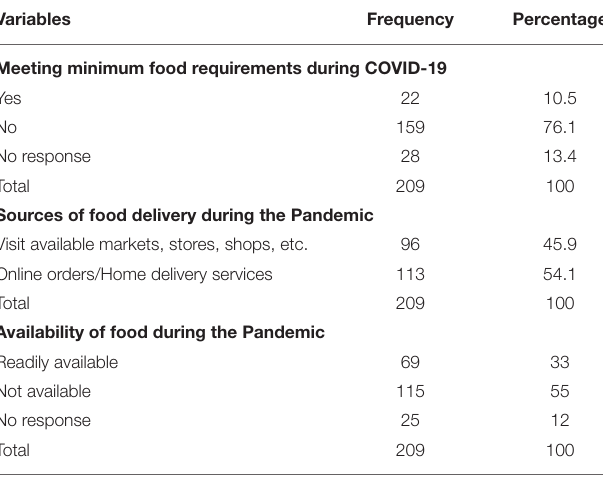
TABLE 6 | Factors affecting food availability, accessibility, and use during the Pandemic.